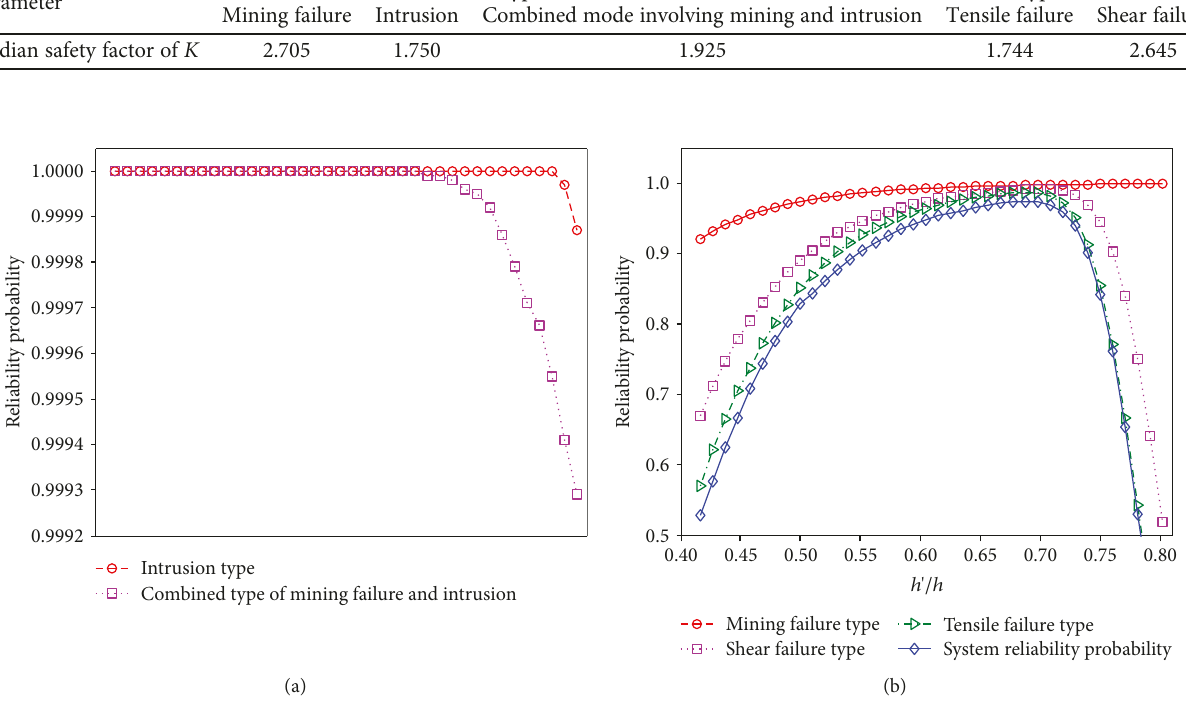
Figure 9: Relationship between the position of key strata and reliability probability. (a) Failure modes of intrusion type and the combined type of mining failure and intrusion and (b) mining failure, shear and tensile failure of key strata, and failure mode of the system.